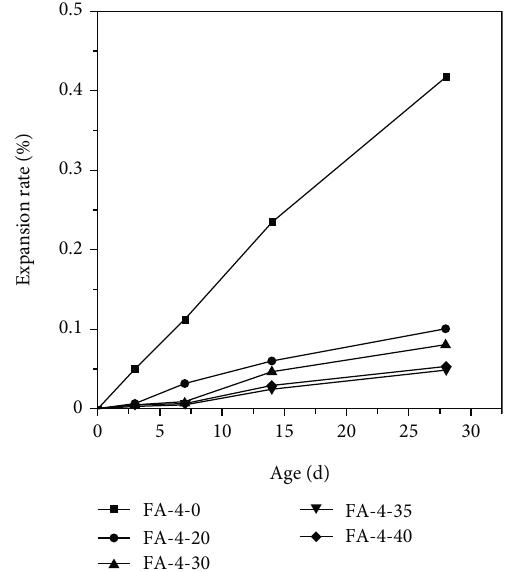
Figure 12: Graph of the expansion rate of the specimen and the amount of coal ash content (cement alkali content